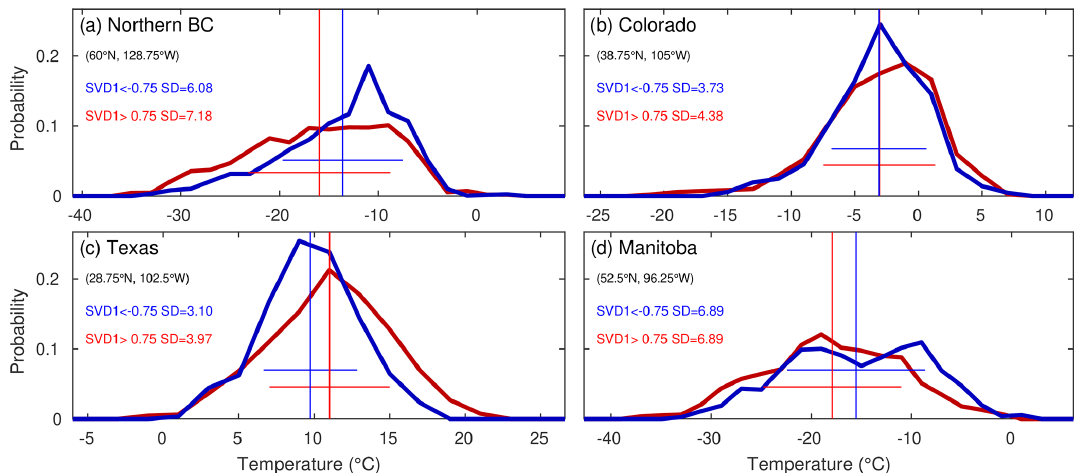
Figure 11. Probability density of temperature at four reference locations (indicated with letters in Fig. 10). Statistics are reported separately for SVD1 SST > 0 . 75 (red) and SVD1 SST < − 0 . 75 (blue). The standard deviation (SD) is reported in each panel and illustrated with horizontal lines as intervals of 2 SD. The means of the distributions are indicated with vertical